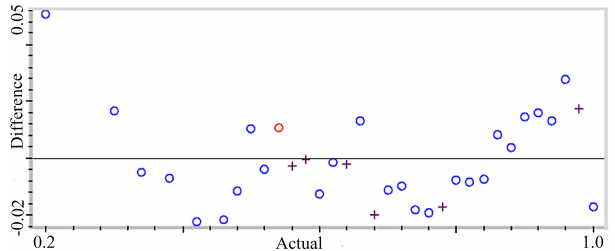
Fig. 4. This plot shows the di®erences between the calculated values relative to the actual values and the absolute value not more than 0.05 and the average value was 0.02, which sug- gested the accuracy of the model.